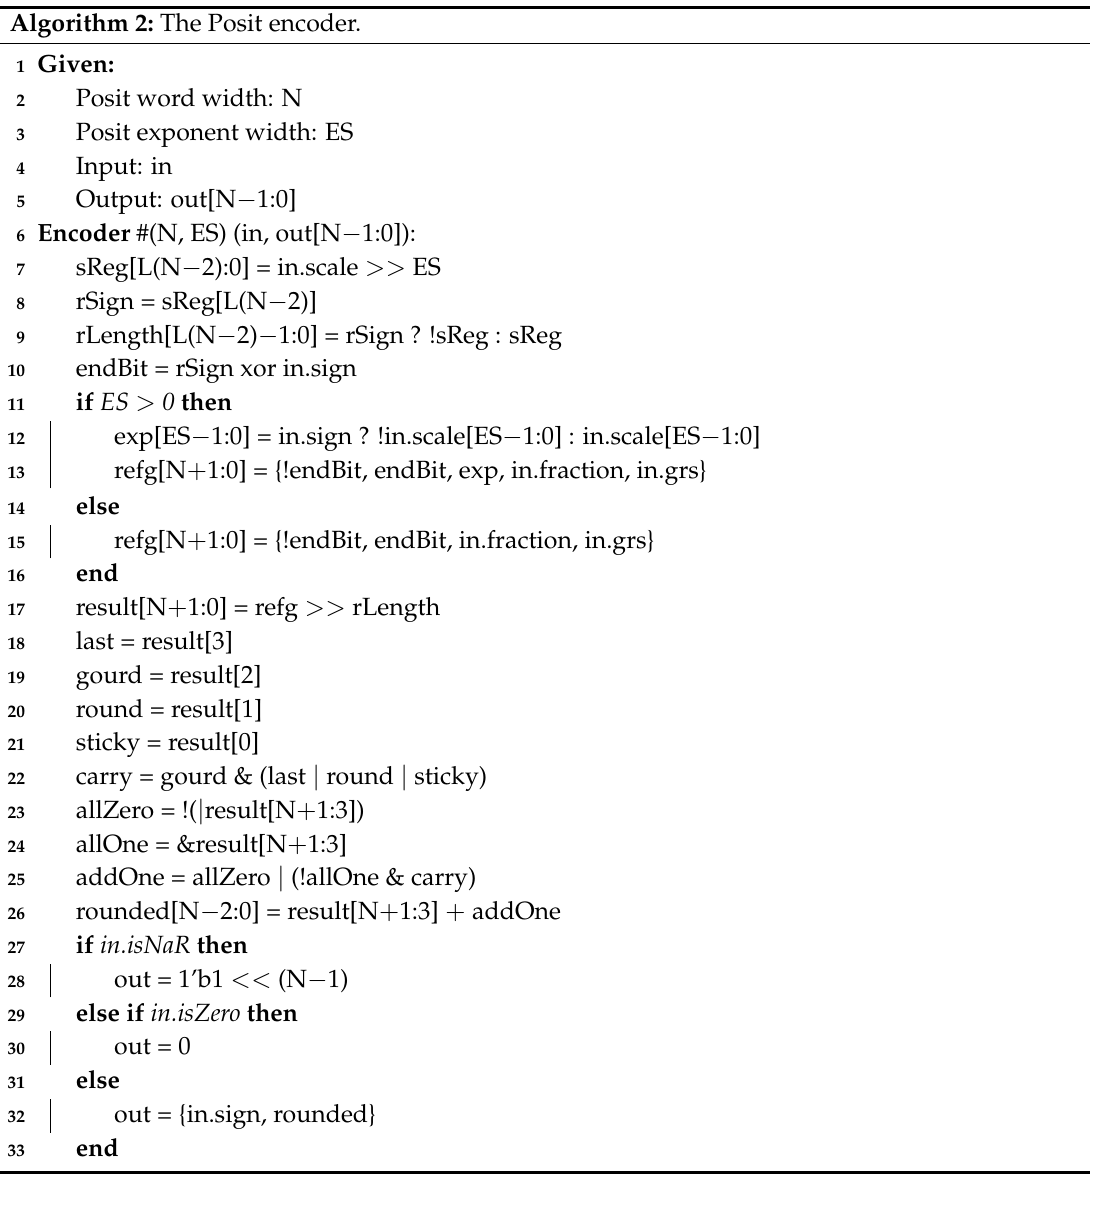
Algorithm 2: The Posit